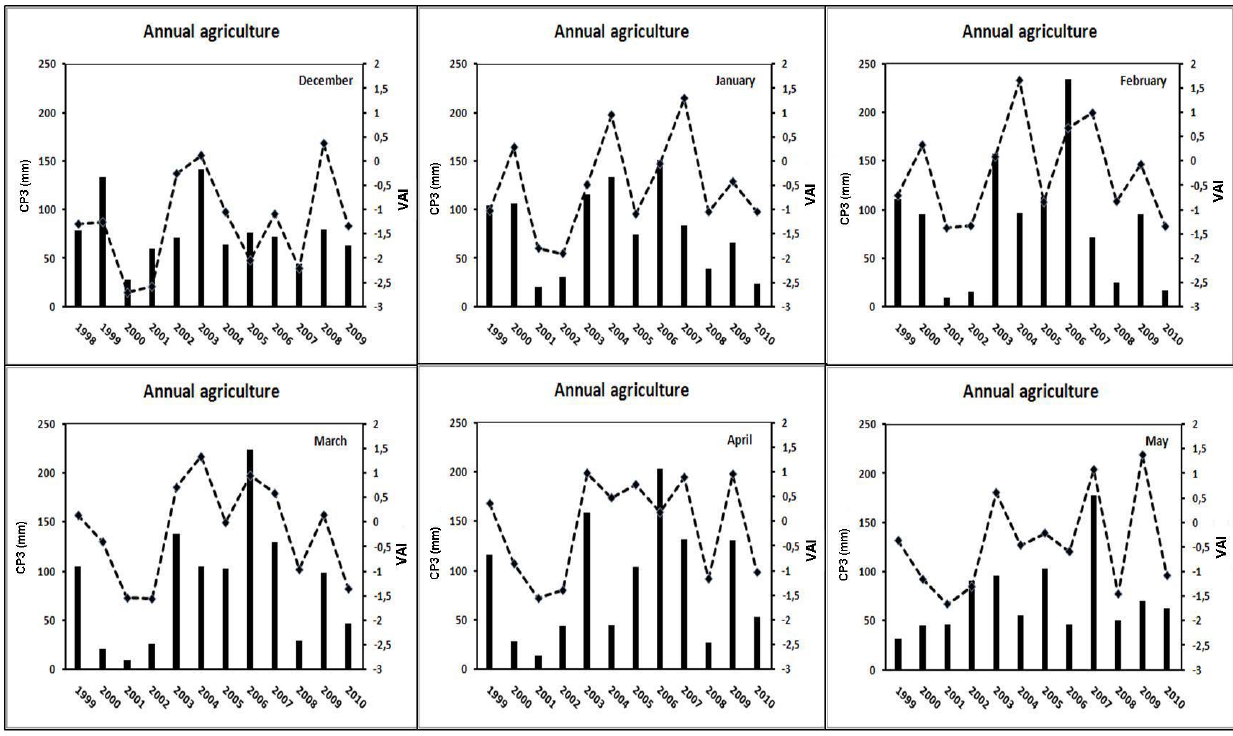
Figure 8. Variations in the VAI , for each month between December and May, for the case of an ―annual agriculture‖ vegetation